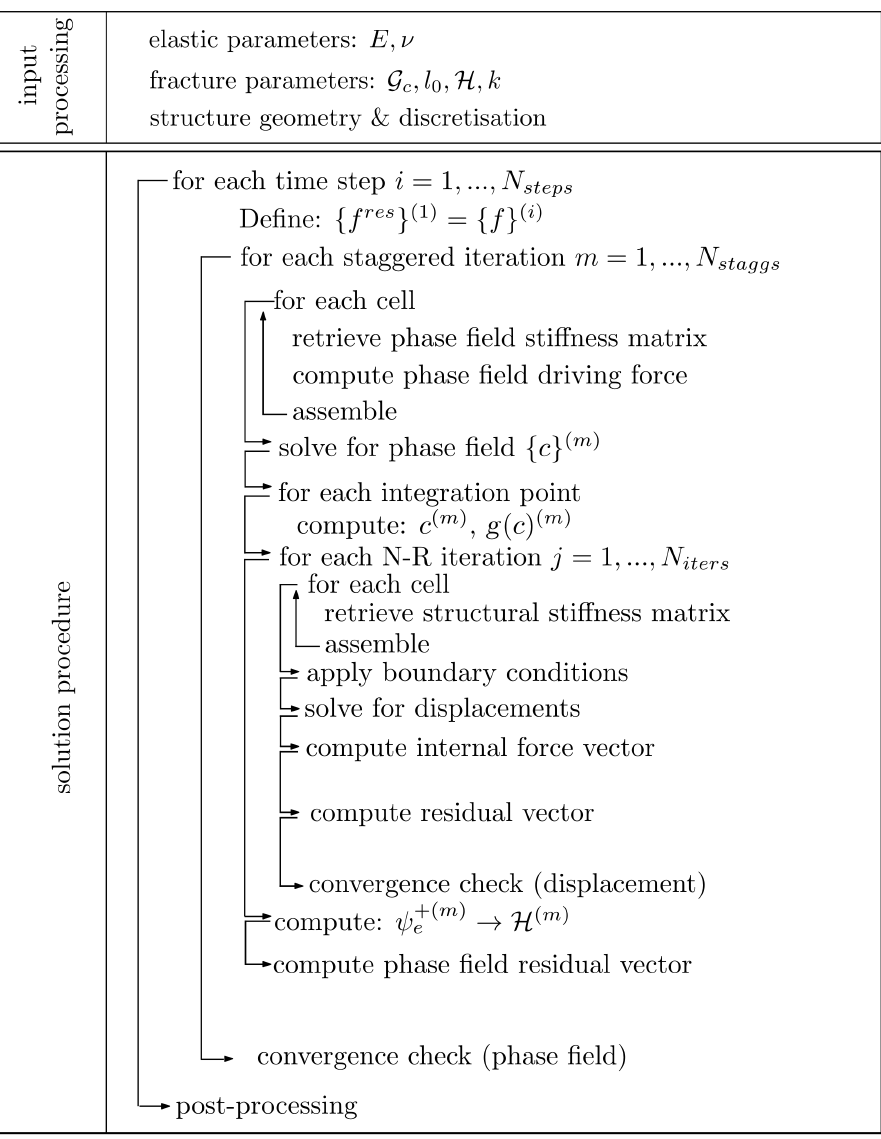
Figure 43. Steps comprising Phase field